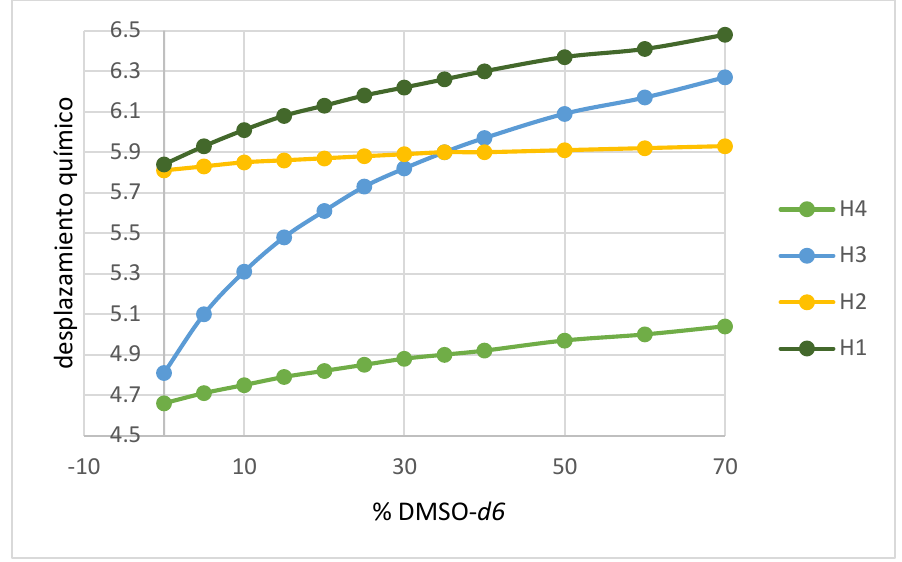
Figure 8. DMSO- d6 titration of a 2 μM sample of 3 at +25 °C (CDCl 3 , 500 MHz). Figure 8. DMSO-d6 titration of a 2 µ M sample of 3 at +25 ◦ C (CDCl